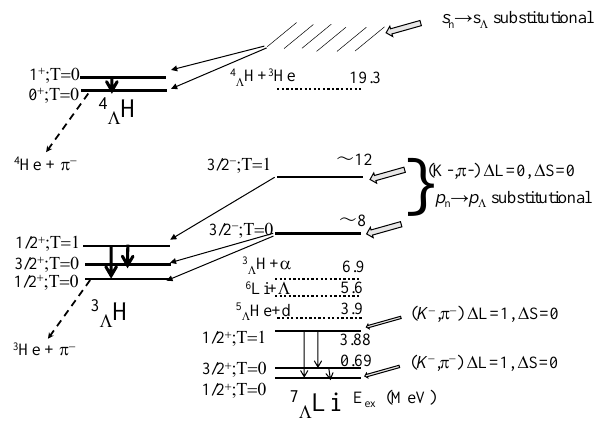
Figure 3. Level scheme of the 7 (cid:3) Li and the particle emission decay from the highly excited state of the 7 (cid:3) Li.